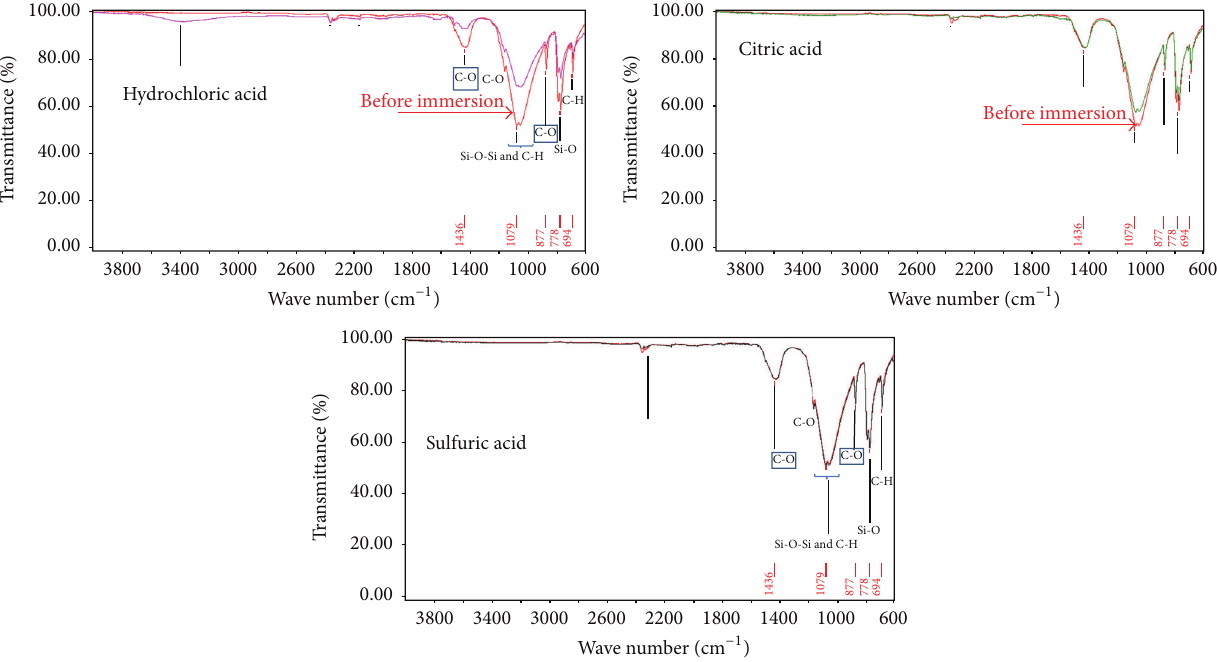
Figure 14: FTIR spectra of micropolymer concrete MPCm before and after 6 months of exposure to different selected acid solutions.